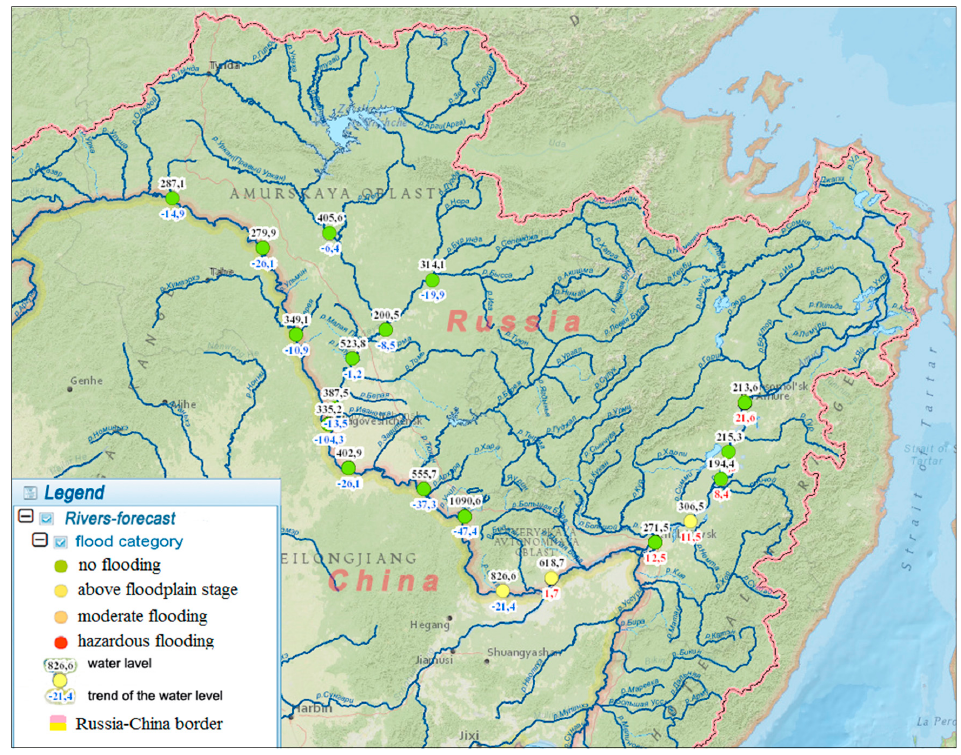
Figure 2. Hydrological forecasts and warnings of the hydrological state at the main cities of the Amur River.